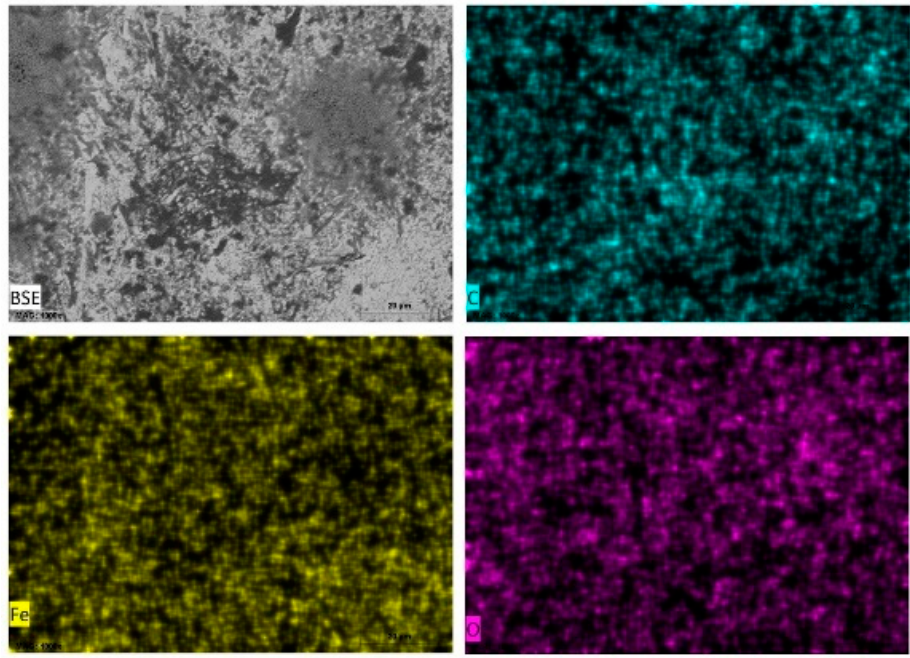
Figure 8. SEM/EDS mapping images of carbon steel sheet (CR1 ≈ EN 1.0338) surfaces after immer- sion in orange juice (pH = 3.58).